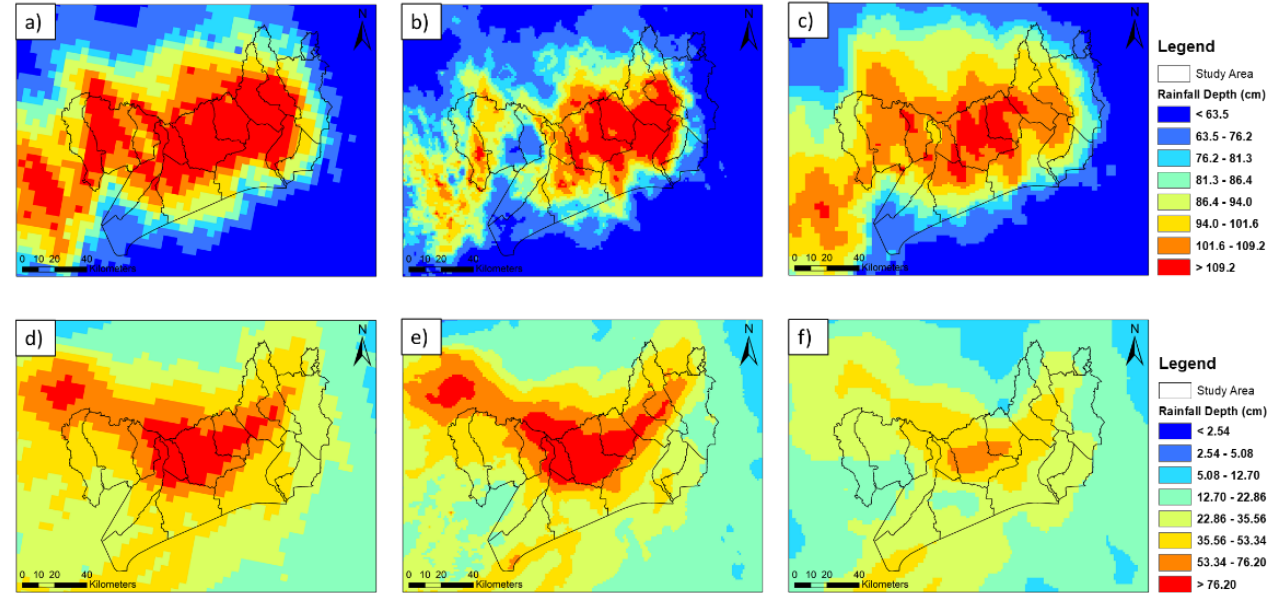
Figure 4. ( a ) Original Stage IV of Hurricane Harvey, ( b ) Original MRMS of Hurricane Harvey, ( c ) Original RTMA of Hurricane Harvey, ( d ) Original Stage IV of Tropical Storm Imelda, ( e ) Original MRMS of Tropical Storm Imelda and ( f ) Original RTMA of Tropical Storm Imelda.